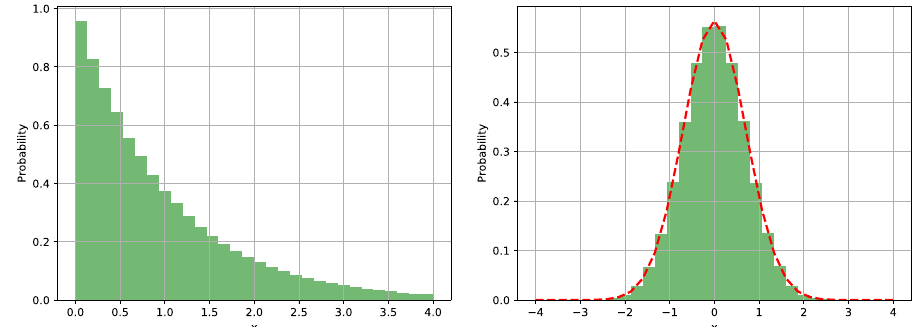
Figure 3: The application of MH algorithm to sample some simple target distribu- tions. See text for